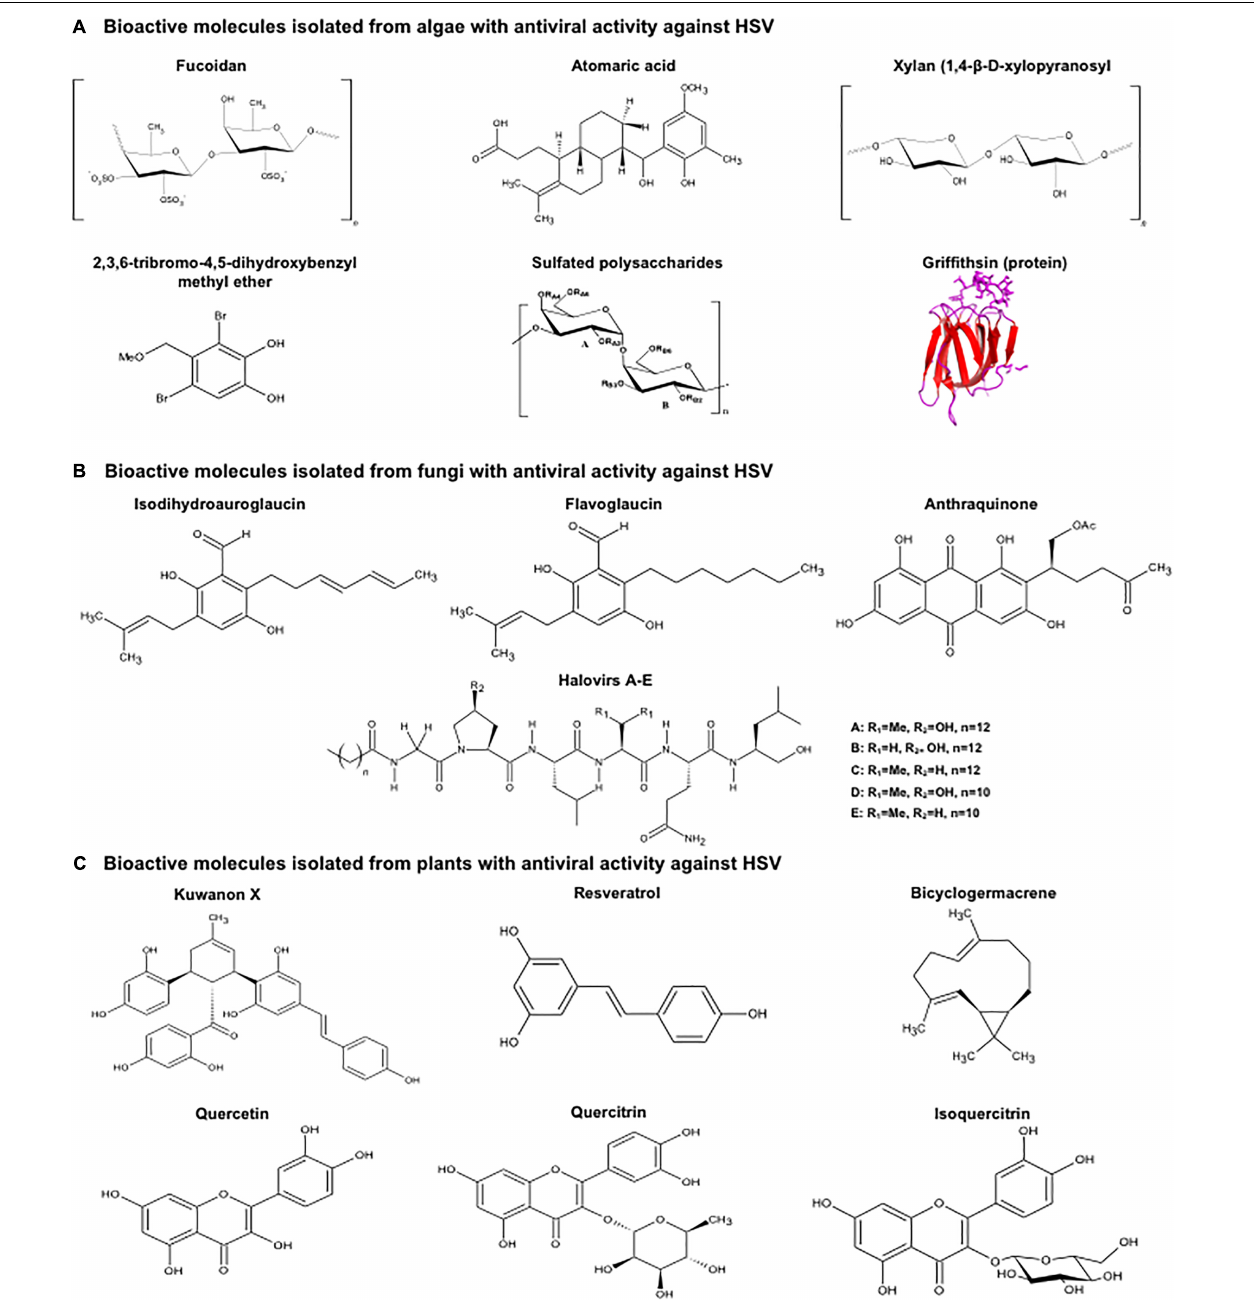
FIGURE 1 | Structure of botanical molecules with antiviral activity against herpes simplex viruses. Structure of molecules derived from (A) algae, (B) fungi and (C) plants that have been reported to have antiviral activity against HSV-1, HSV-2 or both viruses. Molecular structures were drawn using ACD/ChemSketch TM , (version 2018.1.1, Advanced Chemistry Development, Inc., Toronto, ON, Canada, www.acdlabs.com, 2019). Griffithsin (Protein Data Bank accession number 2GUD) was modeled using PyMOL TM (Molecular Graphics System, Version 1.3, Schrödinger,